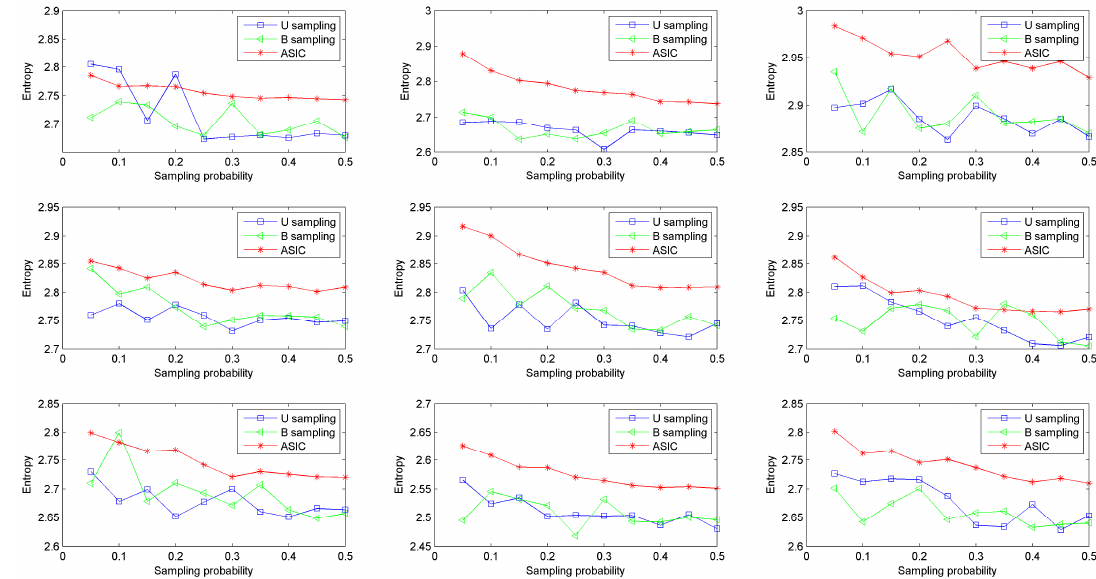
Figure 5. Comparison of entropy.